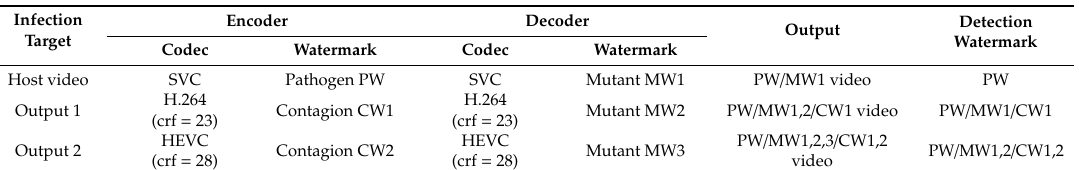
Table 2. Infectious simulation scenario 1 using H.264/MPEG-4 AVC and HEVC for high resolution (128-bit watermark).